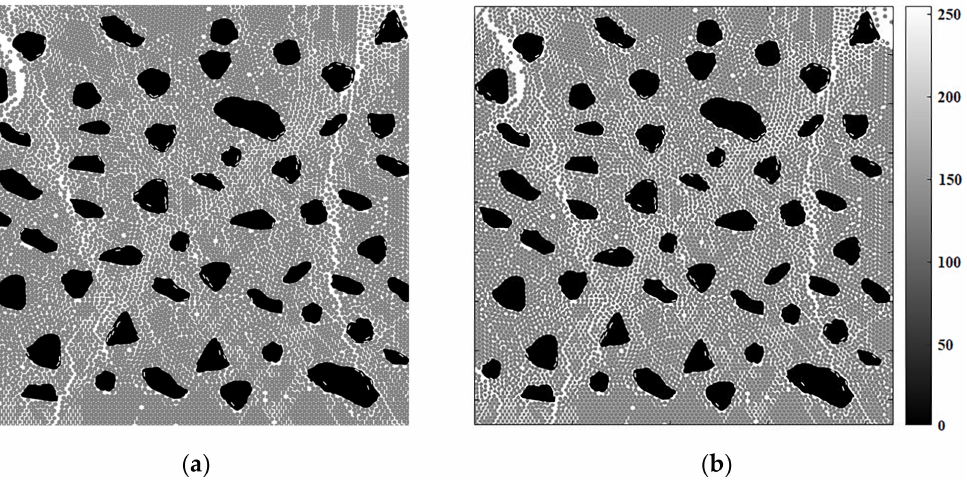
Figure 12. Comparison of the damage map and damage gray map: ( a ) damage map; ( b ) damage gray